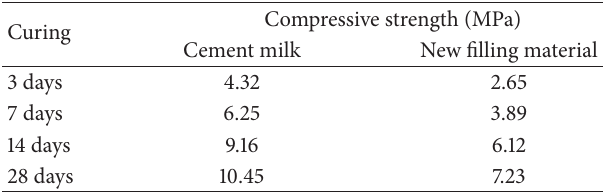
Table 4: Compressive strength results according to filling